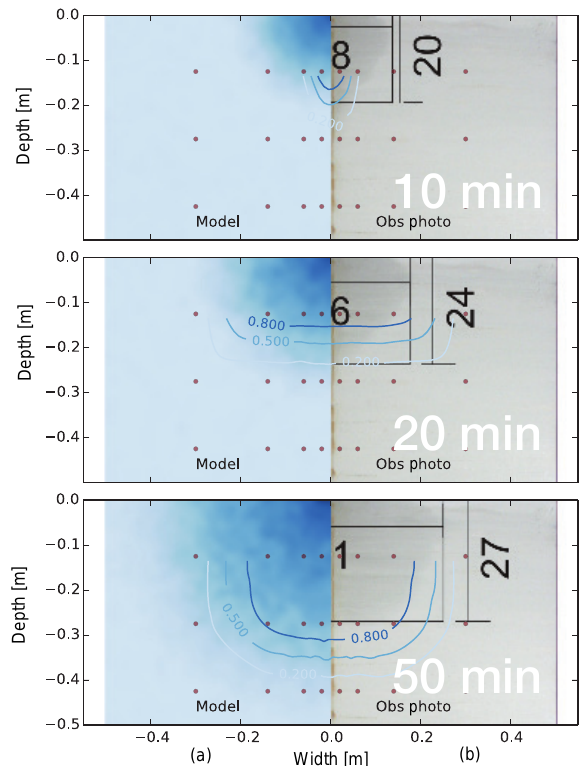
Figure D1. Diffusive exfiltration from an irrigated artificial macro- pore. Experiment by Germer and Braun (2015). The irrigation rate was 3.78Lh − 1 . (a) : model simulation of relative saturation (the half cylindrical column is assumed as planar column). (b) : observed photograph of proceeding wetting front (vertical and lateral extent marked by black annotation). Contour lines: relative saturation cal- culated and interpolated from tensiometer (red dots)